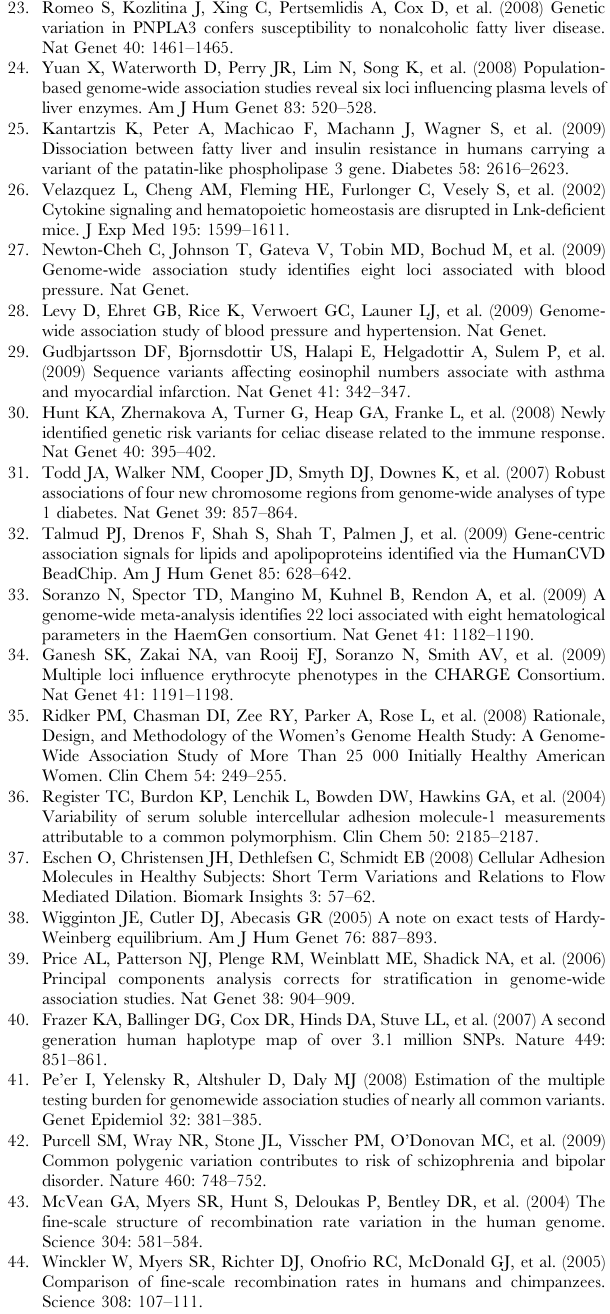
Table S2 Clinical characteristics of